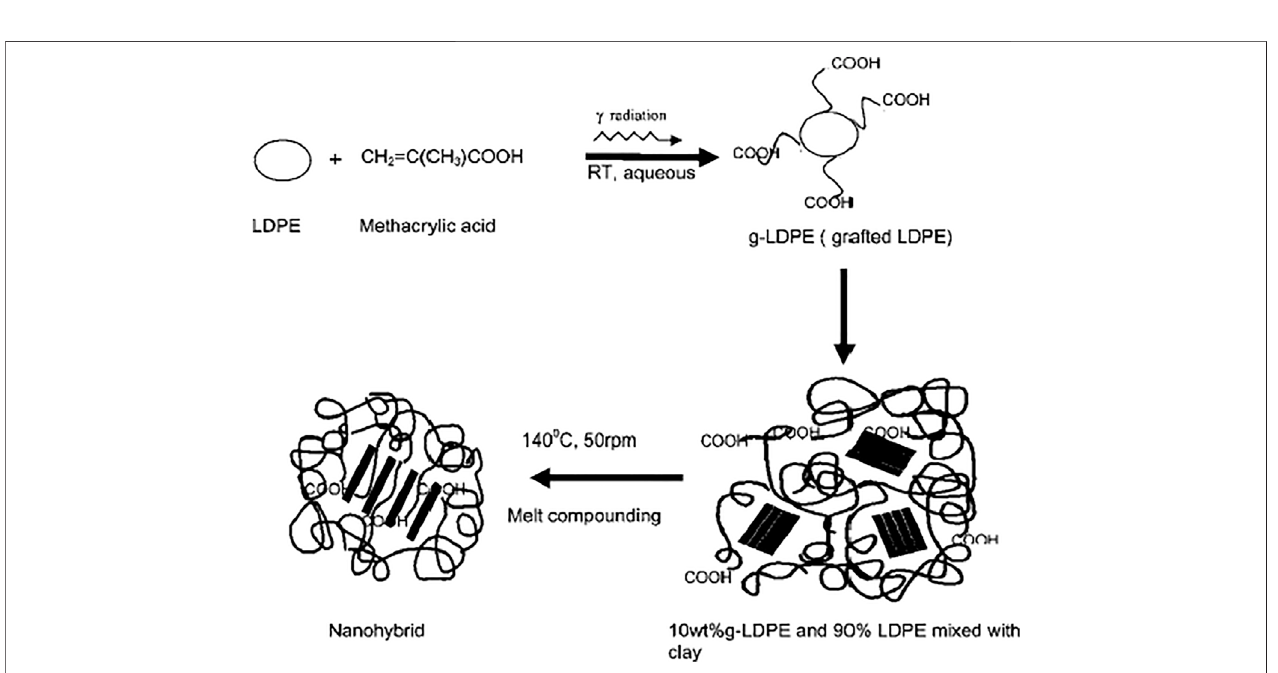
FIGURE 5 | Schematic diagram of gamma grafted MAA-g-LDPE and nano clay composite.